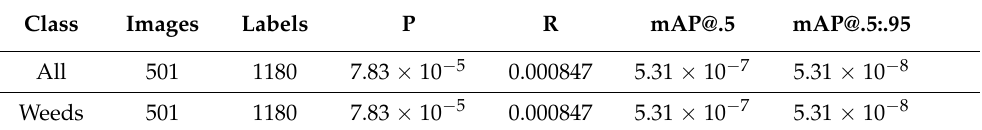
Table 5. Test results on the CP test set using the YOLOv7 model pretrained on the LB dataset. Class